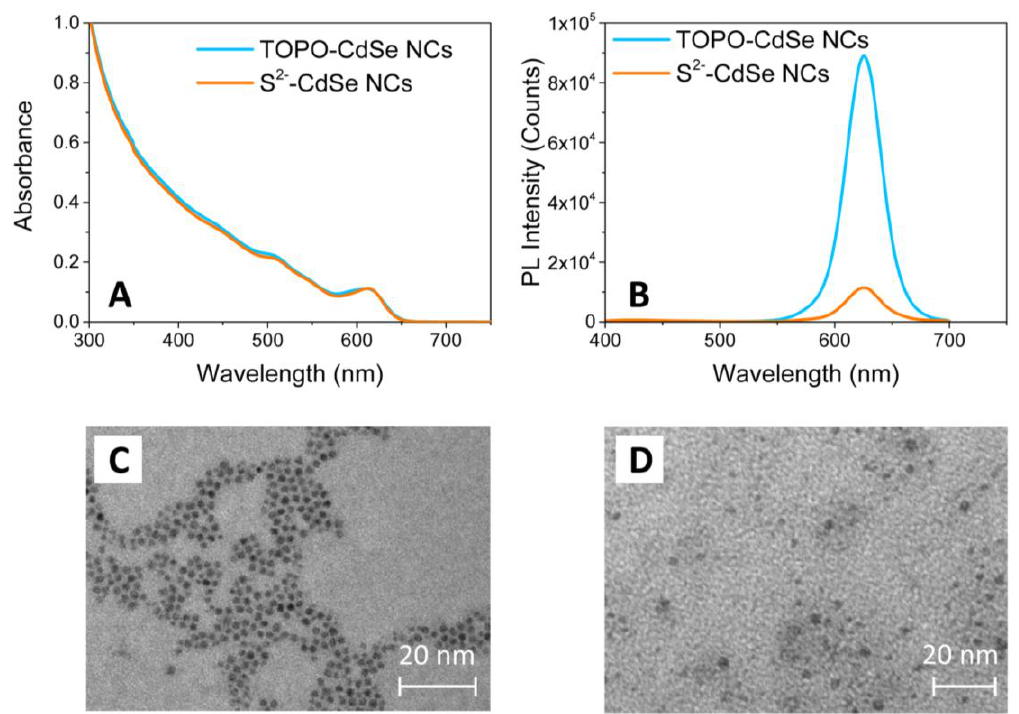
Figure 2. ( A ) UV-Vis absorption and ( B ) PL emission spectra (λ TOPO-capped and S 2− -capped CdSe NCs CHCl images of ( C ) pristine TOPO-capped CdSe NCs and ( D ) S 2− -capped CdSe